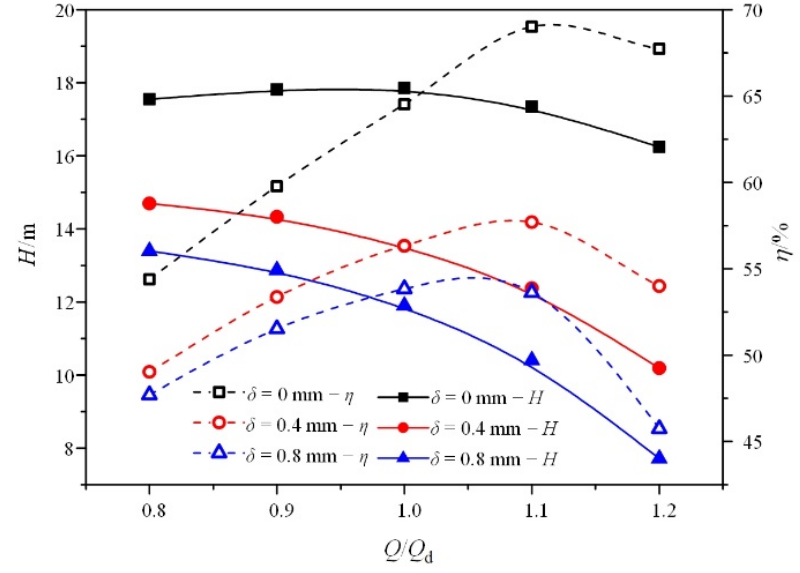
Figure 14. Energy performance of different tip clearance sizes.